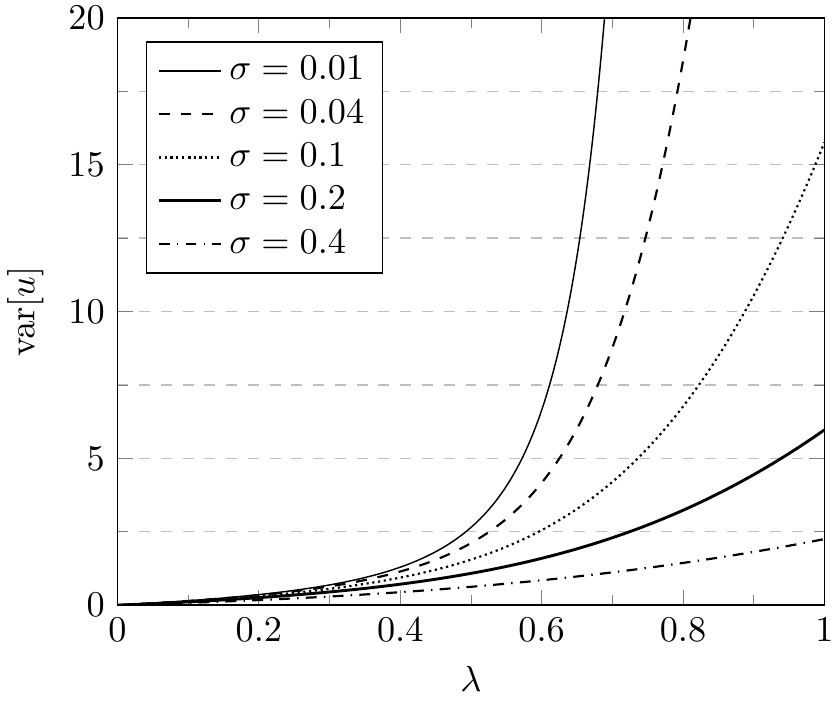
Figure 2. Variance of the system content var [ u ] versus λ , for Poisson arrivals, geometric service times with µ = 0.75 and different values of σ